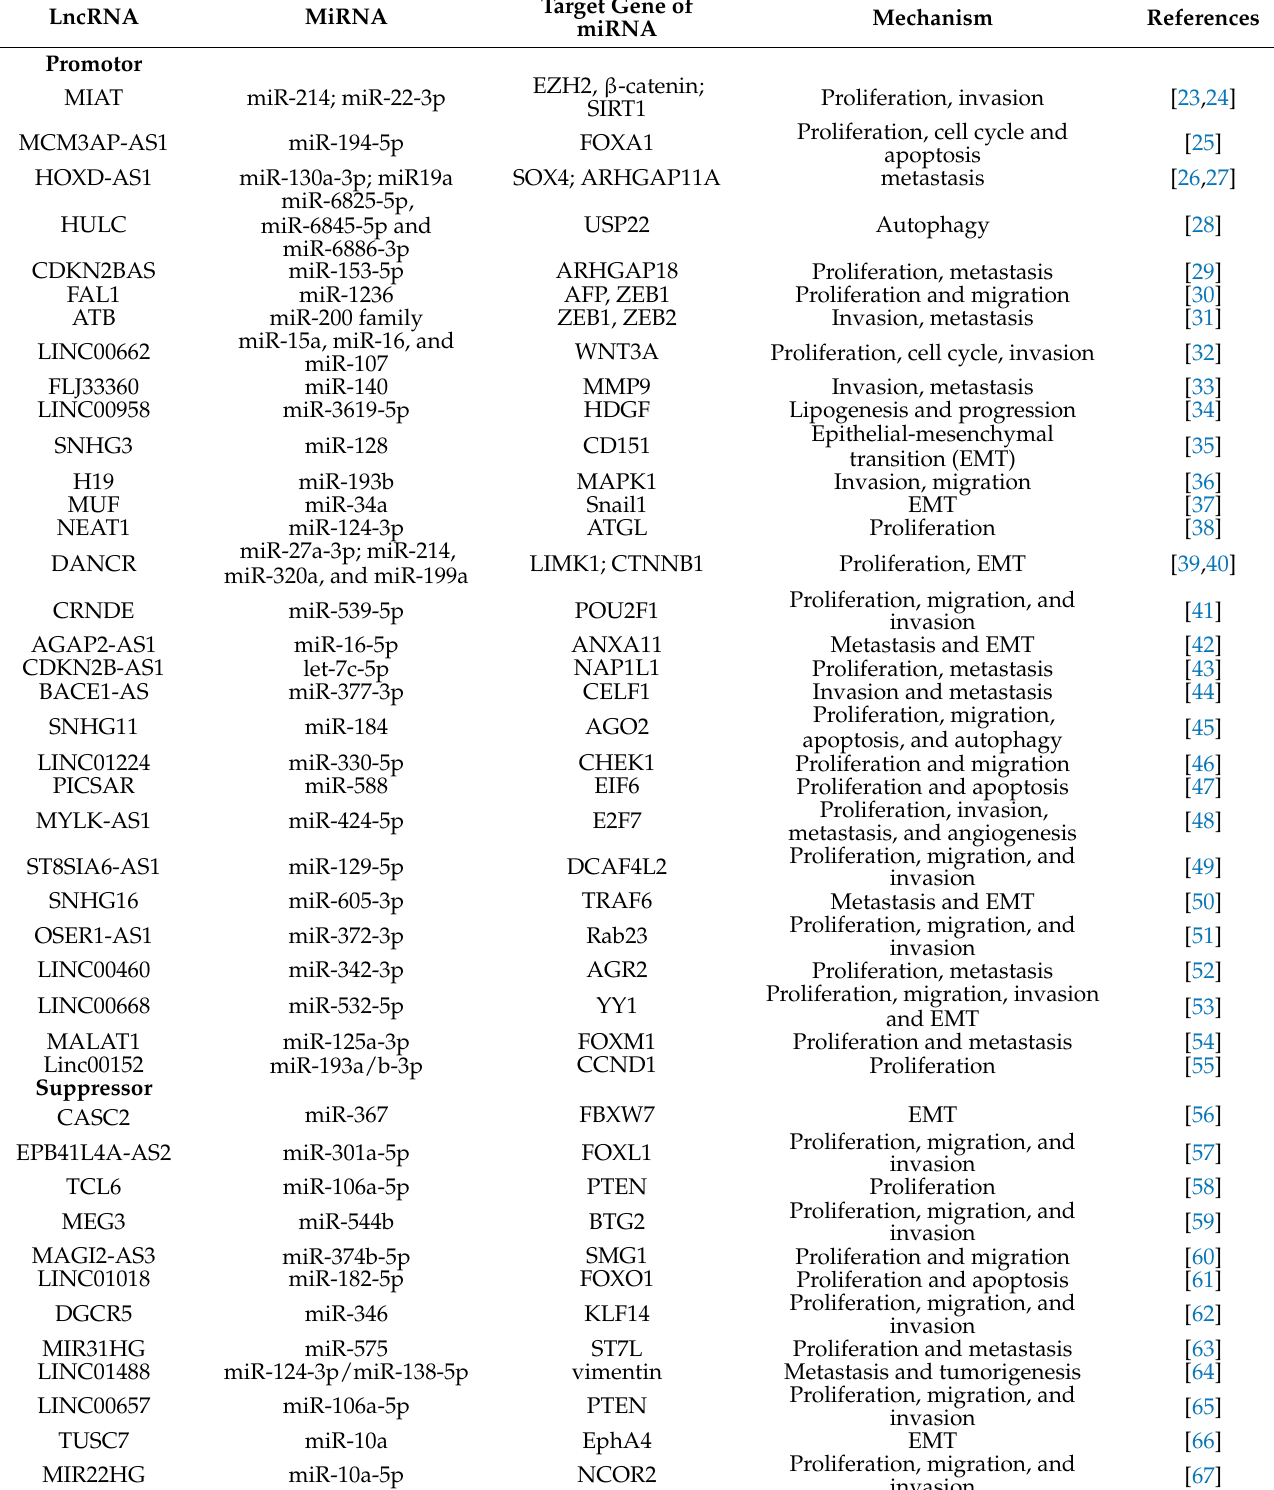
Abbreviations: LncRNA, long non-coding RNA; miR,